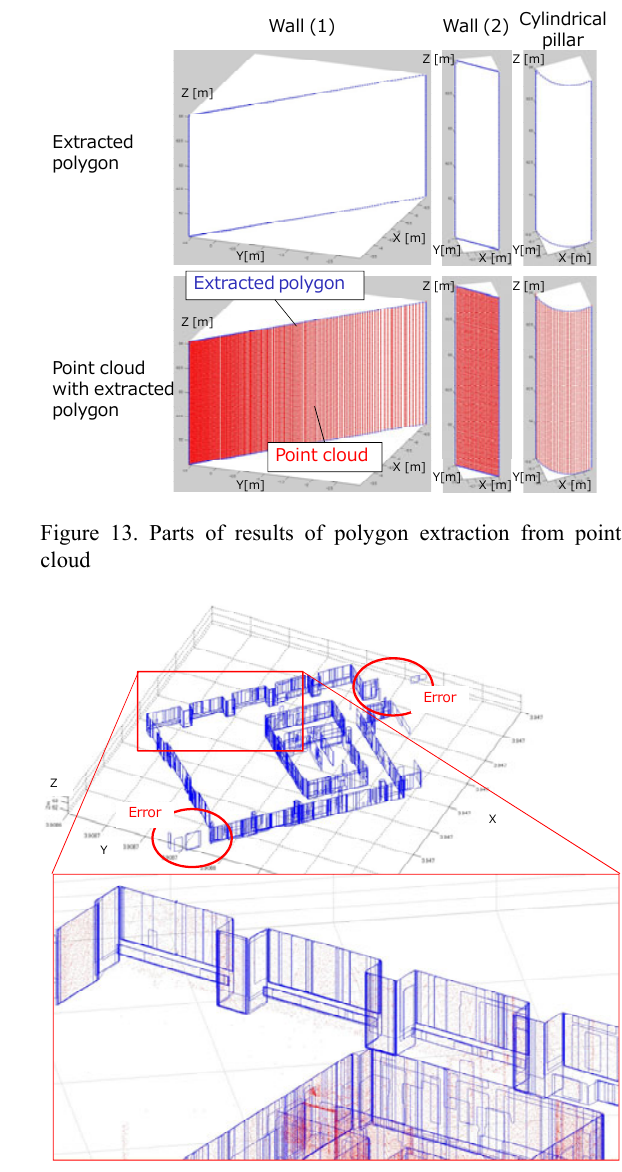
Figure 14. Integrated results in polygon extraction from 72 viewpoints Moreover, the extraction of some features from the point cloud affected by occluded areas and LiDAR measurement noise.